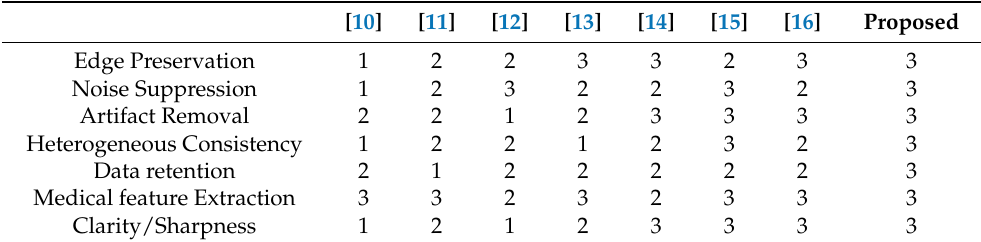
Table 4. Visual analysis from the